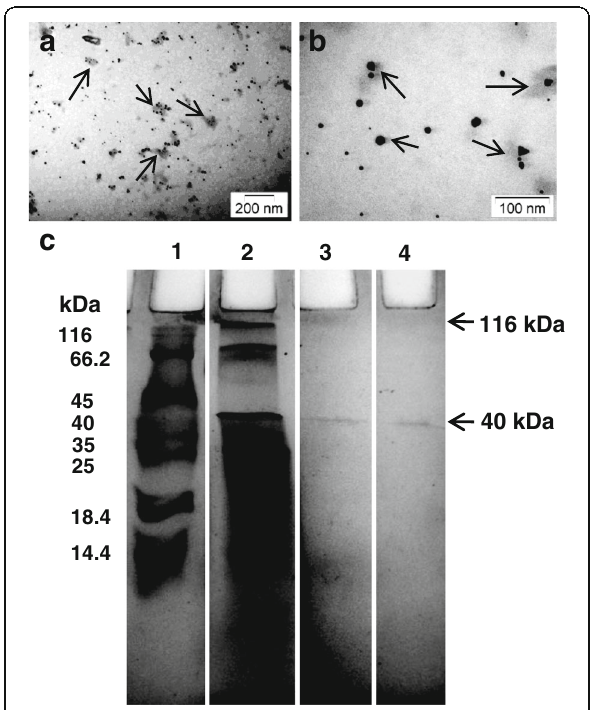
Fig. 9 Protein cap analysis. a , b TEM images showing capping protein layer (arrows) around AuNPs. c SDS-PAGE of extracellular protein secreted from T. crassum and protein associated with nanoparticles.